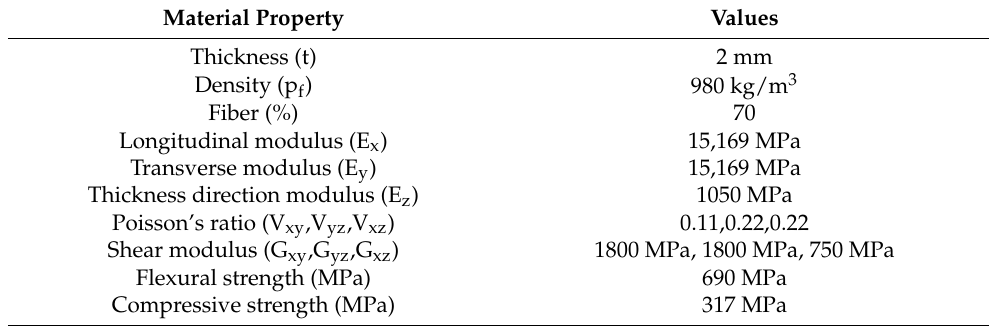
Table 2. Material parameters of